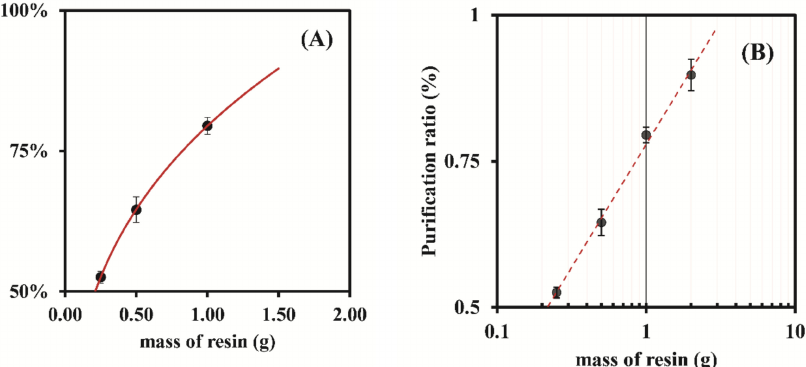
Figure 6. ( A )—Variation of the Purification ratio (%) at 15 min of adsorption time, with the different masses of resin; ( B )—Confirmation of the variation of the Purification ratio (%) at 15 min of adsorption time, by varying the resin mass between 0.25–2.00 g (logarithmic scale for the resin mass).